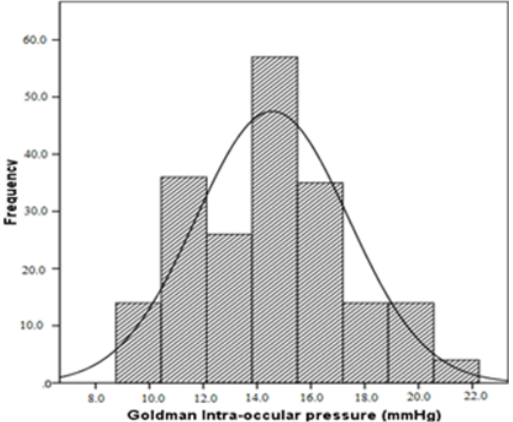
Figures 2: Histograms showing the distribution of IOP of the subjects ( N = 200). The mean IOP of the population was 14.6 mmHg.